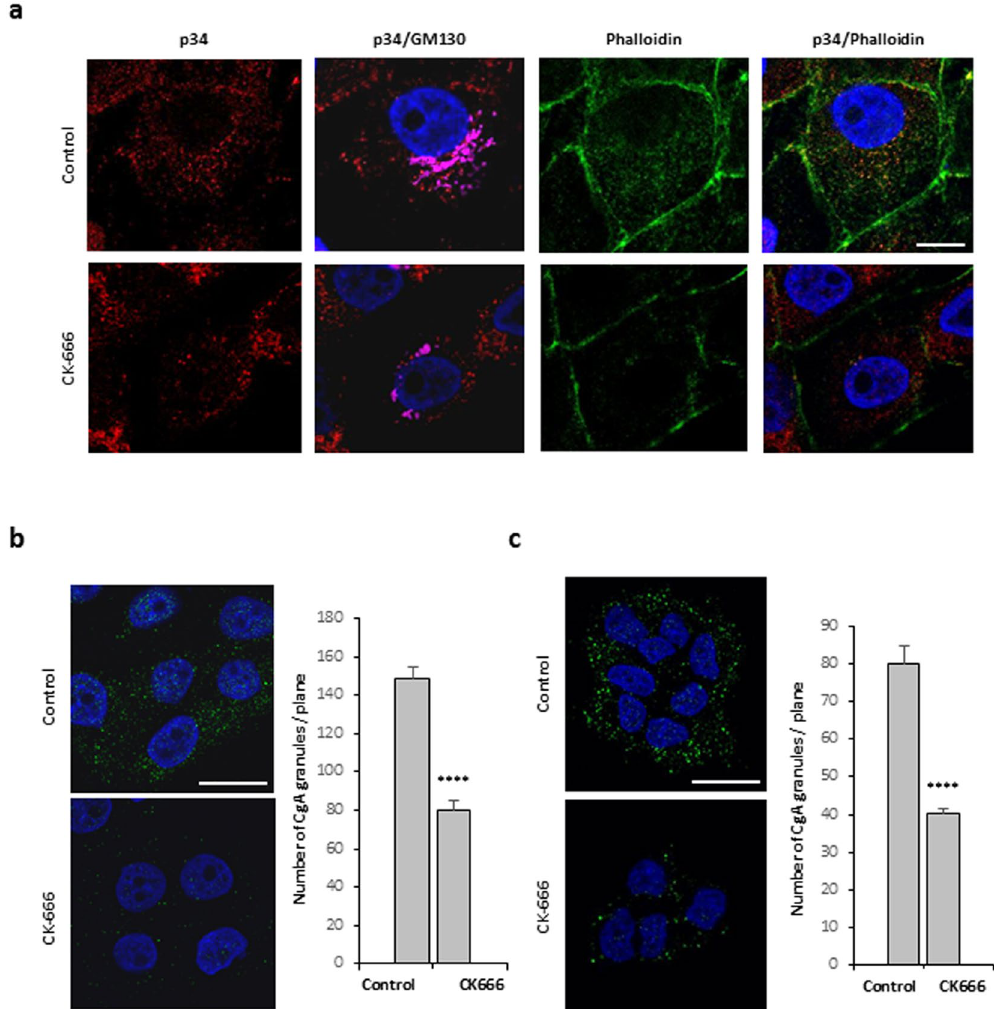
Figure 6. Arp2/3 complex activation is required for the biogenesis of secretory granules. ( a ) COS7-CgA cells were treated with DMSO alone (control) or with the Arp2/3 inhibitor (CK-666). The distribution of the Arp2/3 complex and F-actin was assessed by immunofluorescence with anti-p34 antibody and by fluorescent phalloidin, respectively, and was analyzed by confocal microscopy. A single focal medial plane of GM130 (magenta), p34 (red) and F-actin (green) distribution is shown. Scale bar represents 20 μ m. COS7-CgA cells ( b ) and PC12 cells ( c ) were treated with DMSO alone (control) or with the Arp2/3 inhibitor (CK-666). They were immunolabeled with anti-CgA antibody and analyzed by confocal microscopy. Representative confocal microscopy sections throughout the nucleus are shown. The scale bar represents 20 µ m. The number of CgA granules in cells treated with DMSO alone (control) or with the Arp2/3 inhibitor (CK-666) was quantified and expressed as mean + s.e.m. from three independent experiments (n = 40 cells). **** P < 0.0001 (Student’s t -test with Welch’s